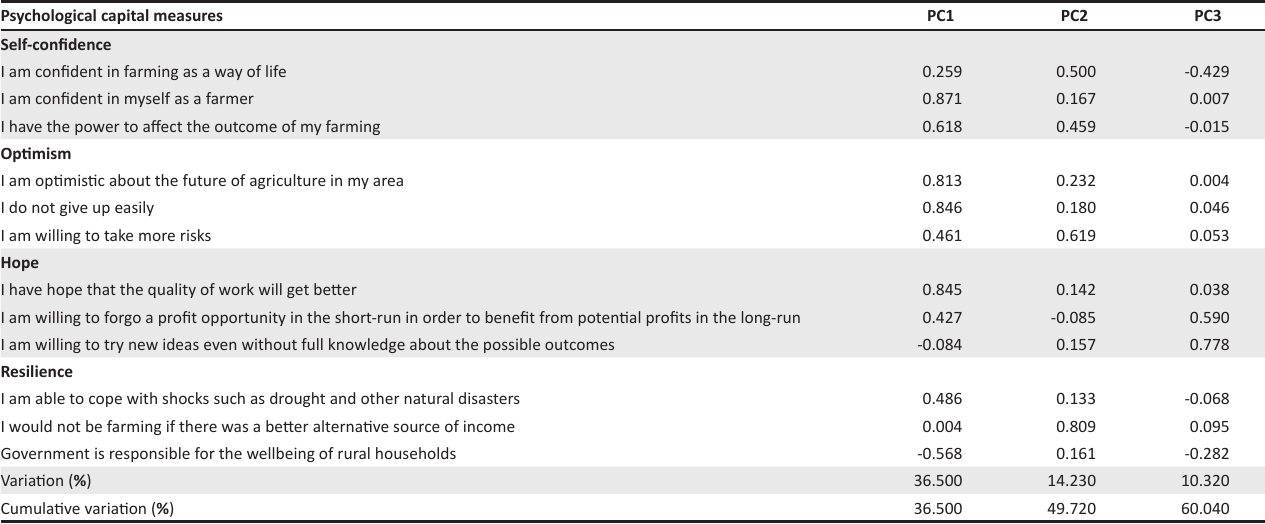
TABLE 1-A1: Principal component analysis results of psychological capital measures. Psychological capital